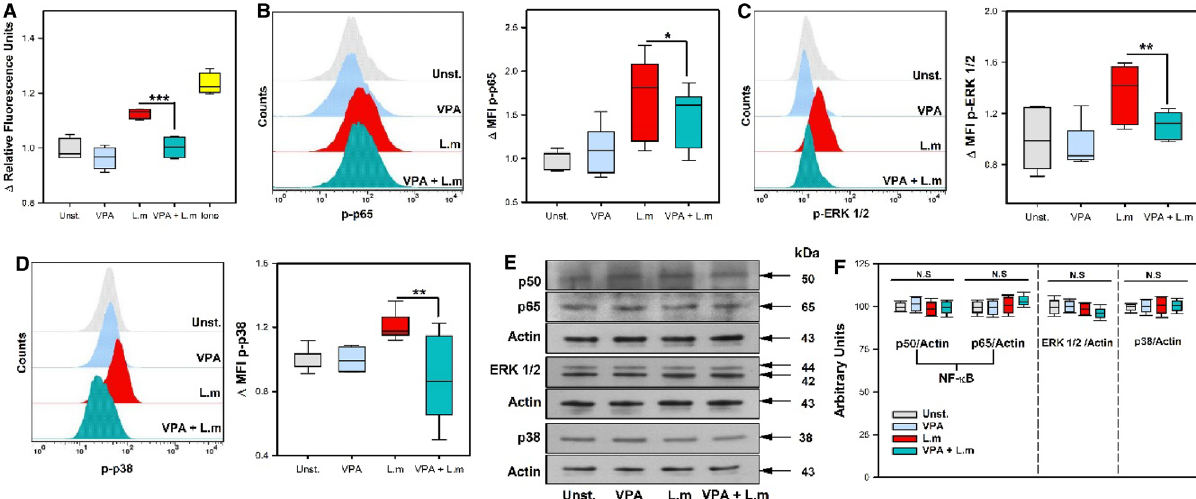
Figure 4. Valproic acid decreases calcium mobilization and phosphorylation of signaling proteins in Listeria monocytogenes -activated mast cells. ( A ) BMMC were pre-incubated with 2 mM VPA for 18 h and then stained with Fluo-4 AM. The baseline Relative Fluorescence Units (RFU) reading was recorded at 0 and 5 min in a fluorescence plate reader. Then, cells were stimulated with L.m or calcium ionomycin (iono), and RFU readings were recorded at 45 min. The panel shows the fold change in RFU with respect to the average value of the baseline RFU for each experimental group. (n = 4 per group; ** p < 0.01; Kruskal–Wallis test). ( B - D ) BMMC were pre-incubated with 2 mM VPA for 18 h and then stimulated with L.m for different times to determine the phosphorylation of ( B ) NF-κB p65 at 30 min, ( C ) ERK 1/2 at 15 min and ( D ) p38 at 60 min by flow cytometry. The left panels show representative histograms of phosphorylated proteins. The right panels show the fold change of the median fluorescence intensity (MFI) with respect to the average value of unstimulated BMMC. (n = 6 per group; N.S = Not Significance, **p < 0.01, *** p < 0.001; Kruskal–Wallis test). ( E – F ) BMMC were pre- incubated with 2 mM VPA for 18 h and then stimulated with L.m for different times to determine the expression of ( E ) NF-κB p50 and p65 at 30 min, ERK 1/2 at 15 min and p38 at 60 min by Western-Blot. ( F ) Immunoblots were evaluated by densitometry. The data are expressed as arbitrary units, considering the average value of